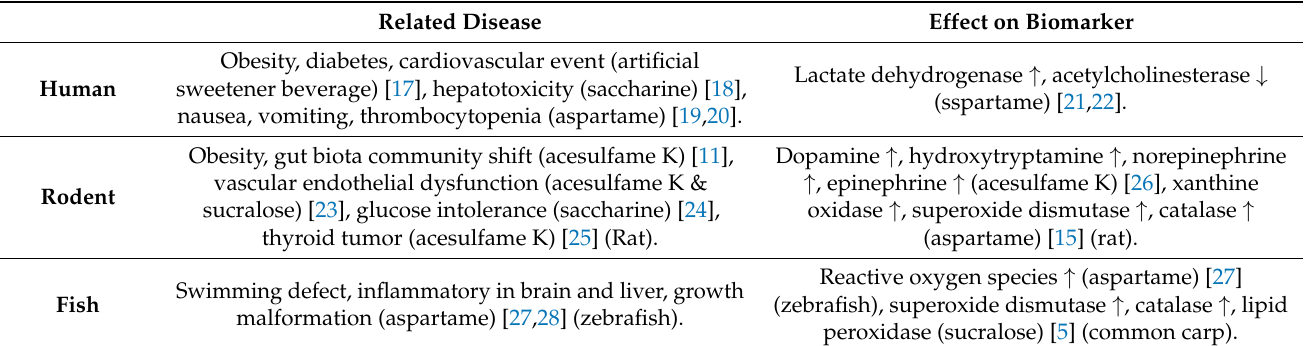
Table 1. Study of related disease and effect on biomarker after artificial sweetener exposure. Related